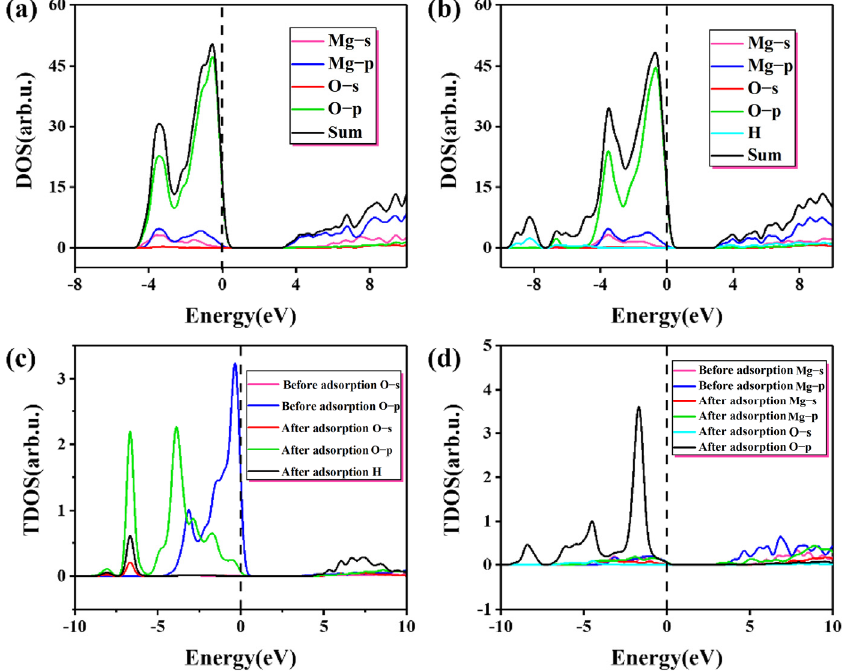
Figure 6. The change in the density of states before and after the adsorption with a coverage of 1.25: ( a ) the density of states before adsorption; ( b ) the density of states after adsorption; ( c ) change in local density of states before and after adsorption at the O site; ( d ) change in local density of states before and after adsorption at the Mg site.